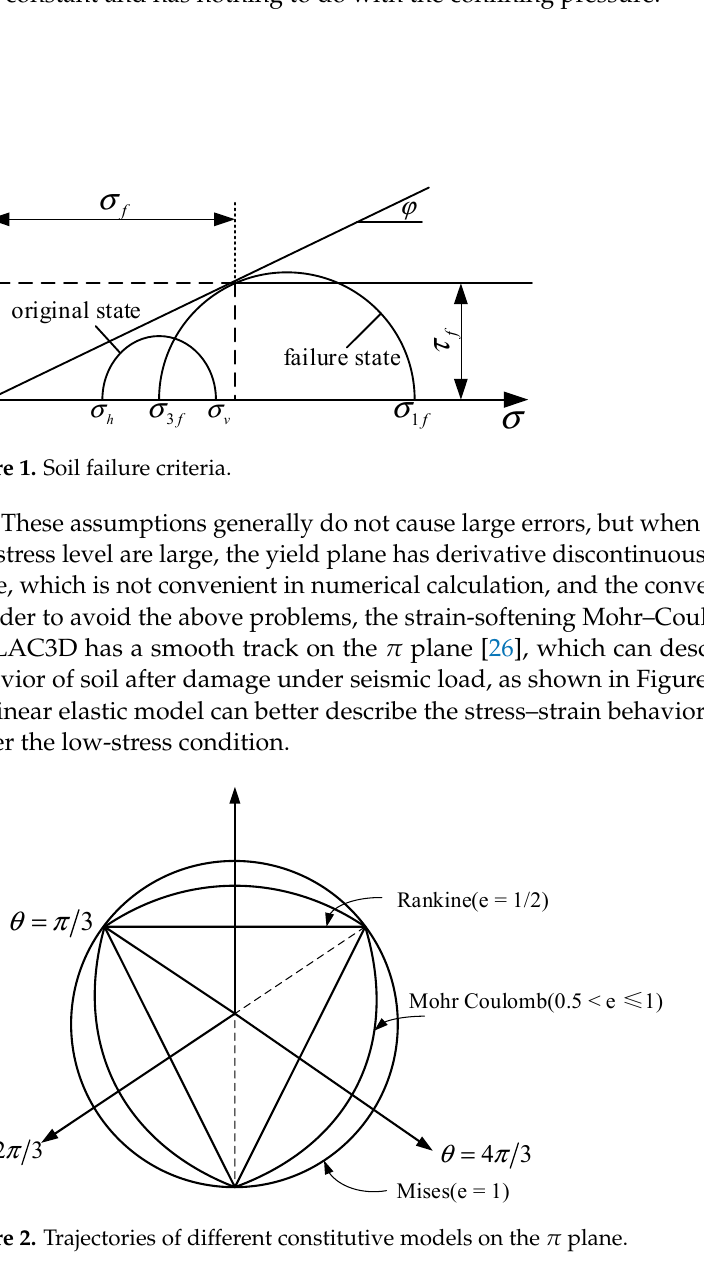
Figure 2. Trajectories of different constitutive models on the π plane.